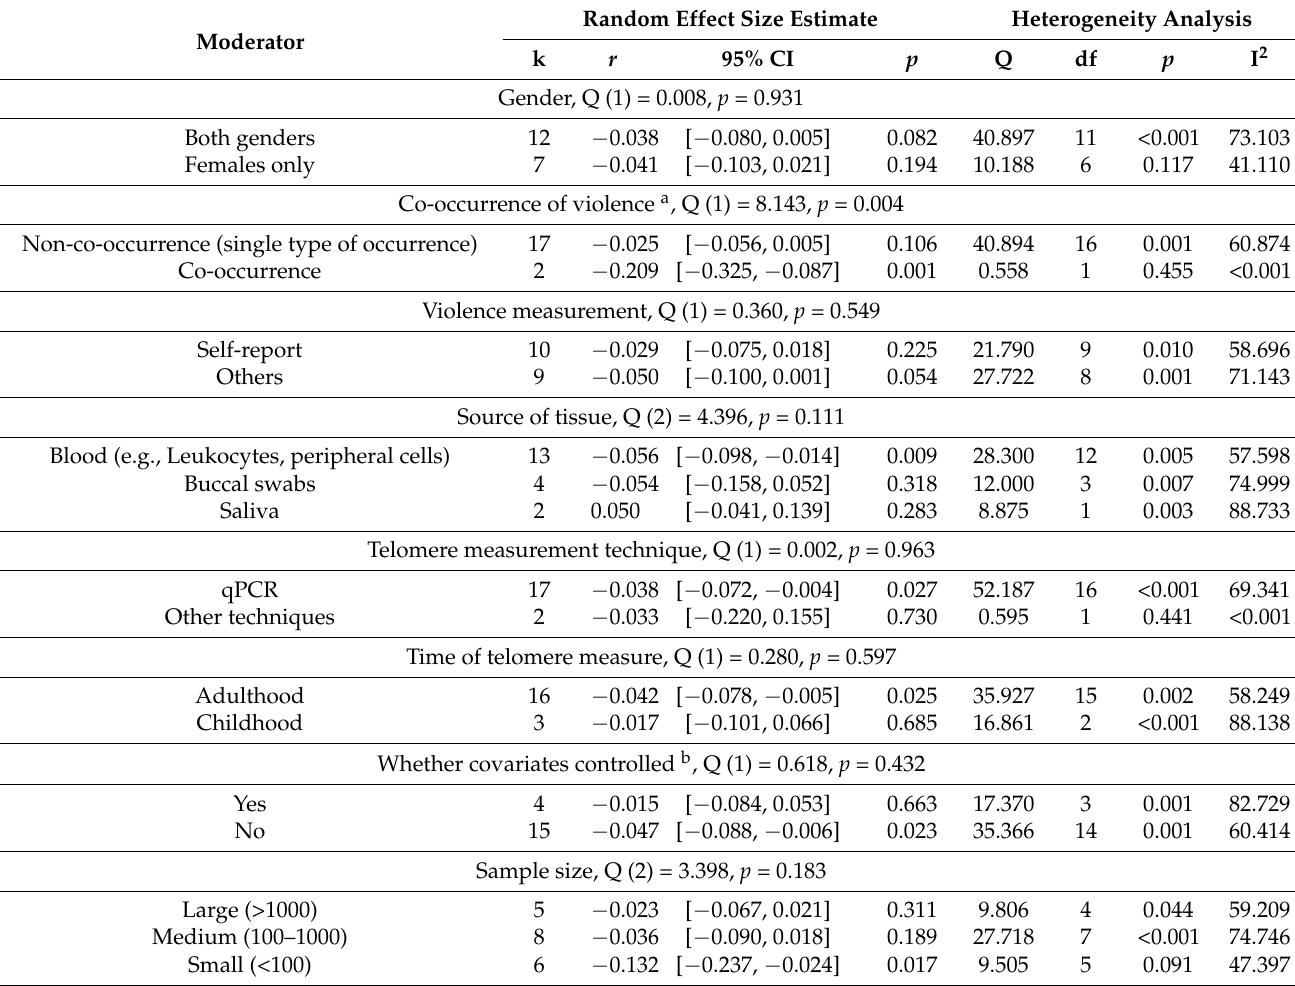
Table 2. Categorical moderator